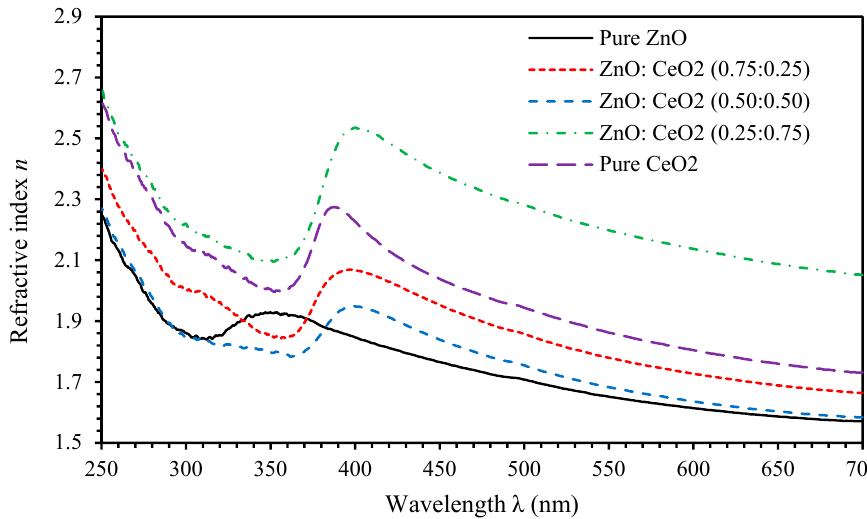
Figure 10. The refractive index spectra of pure ZnO, pure CeO 2 and ZnO:CeO 2 mixed oxides thin films.